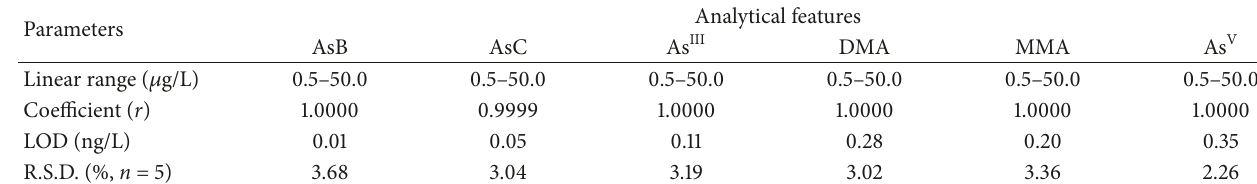
Table 3: Analytical figures of arsenic speciation by HPLC–ICP–MS.